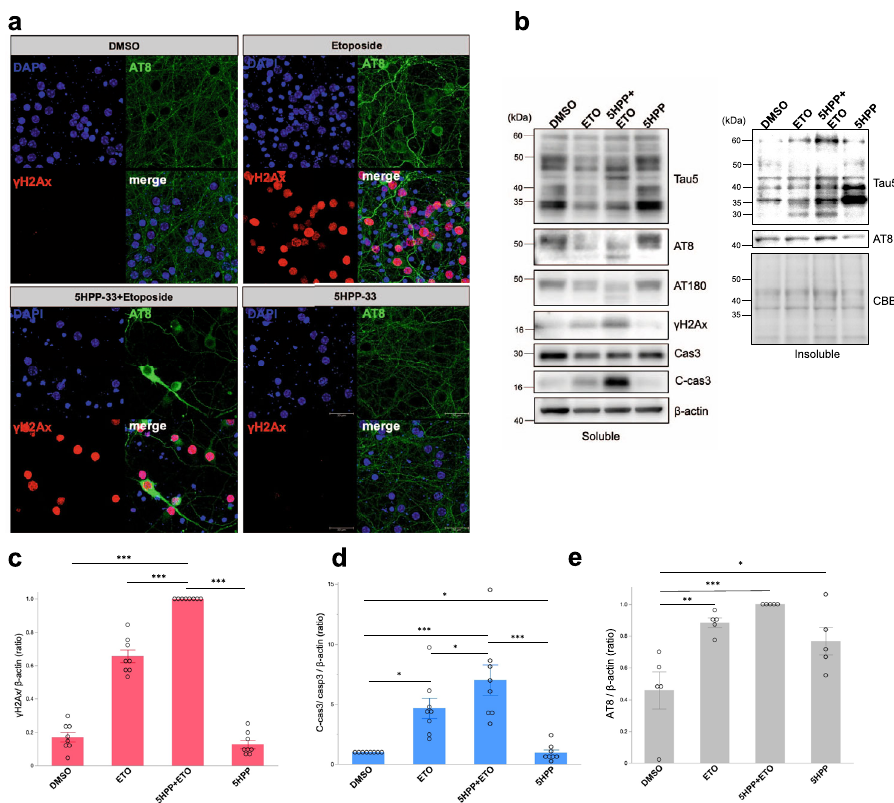
Fig. 7 The effect of microtubule polymerization inhibitor with DSB induction. a Primary mouse cortical neuron cultures (DIV 7) were incubated with DMSO, 50 μ M etoposide (Etoposide), and 2.5 μ M 5HPP-33 (5HPP-33: microtubule polymerization inhibitor) for 24 h. Neurons labeled as (5HPP- 33 + Etoposide) are pretreated by 2.5 μ M 5HPP-33 for 30 mins, followed by incubation with 2.5 μ M 5HPP-33 and 50 μ M etoposide for 24 h. Immuno fl uorescence was obtained using antibodies against p-tau (AT8: green) and γ H2Ax (red). DAPI (blue) was used for labeling the nucleus. Scale bar = 30 μ m. b Western blot analysis of supernatant (soluble fractions, left panel) and pellet (insoluble fractions; right panel) obtained from neurons treated with DMSO, ETO (50 μ M etoposide), 5HPP + ETO (50 μ M etoposide treatment after pretreated by 2.5 μ M 5HPP-33 for 30 mins), and 5HPP (2.5 μ M 5HPP-33). Membranes were probed with anti-total tau (Tau-5), p-tau (AT8 and AT180), DSB maker ( γ H2Ax), caspase3 (Cas3), cleaved caspase3 (C-cas3), and β -actin antibodies. Total proteins of insoluble faction samples were stained by Coomassie brilliant blue (CBB). c Quantitation of γ H2Ax / β -actin in soluble fraction. n = 7, *** p < 0.0001. d Quantitation of AT8 in insoluble fraction. n = 4, * p = 0.0425, ** p = 0.0047, *** p = 0.0005. e Quantitation of cleaved caspase3 in soluble fraction. n = 3 independent experiments. DMSO vs ETO, * p = 0.0176; ETO vs 5HPP + ETO, * p = 0.0496; ETO vs 5HPP, * p = 0.0189; DMSO vs 5HPP + ETO, *** p = 0.0004; 5HPP + ETO vs 5HPP, *** p = 0.0005. Statistical signi fi cance was determined by two-way ANOVA, followed by a Tukey